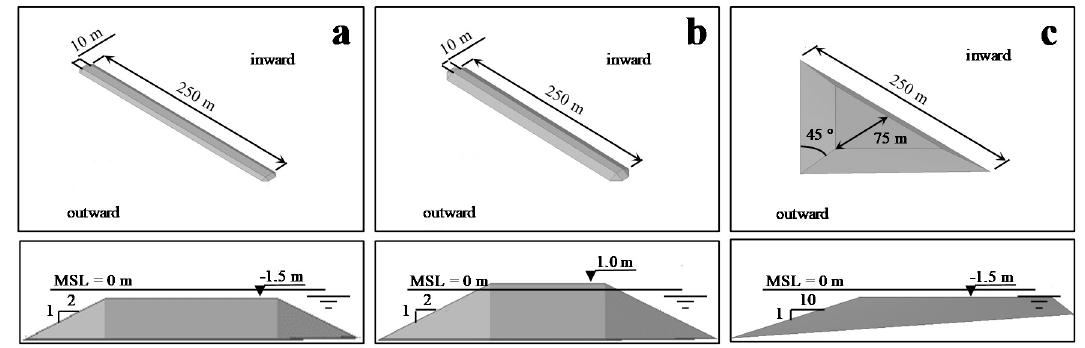
Figure 4. Geometrical shapes considered in this study (upper panel: plan view; lower panel: cross-section): ( a ) submerged detached breakwater; ( b ) emerged detached breakwater; ( c ) multifunctional artificial reefs (MFAR).